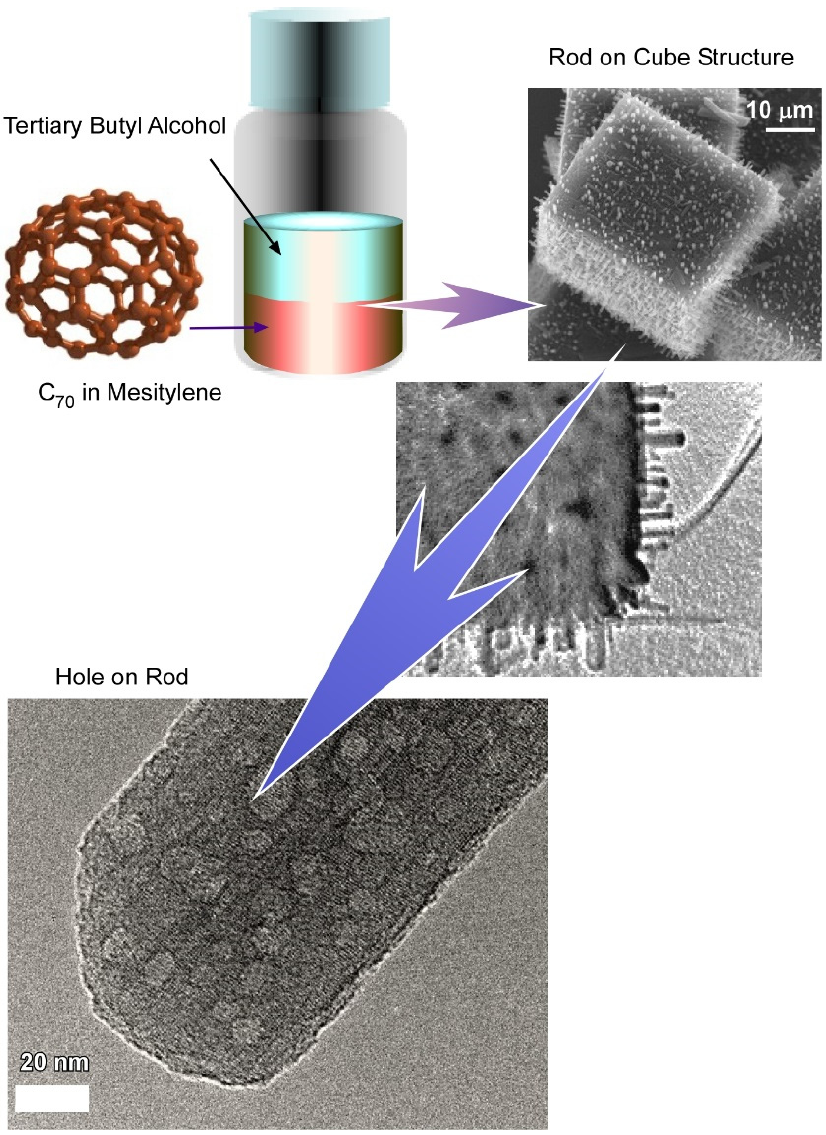
Figure 3. Preparation of hierarchically structured fullerene cubes and mesoporous fullerene C 70 nanorods with crystalline pore walls. Reprinted with permission from Reference [136]. Copyright 2016 American Chemical Society.